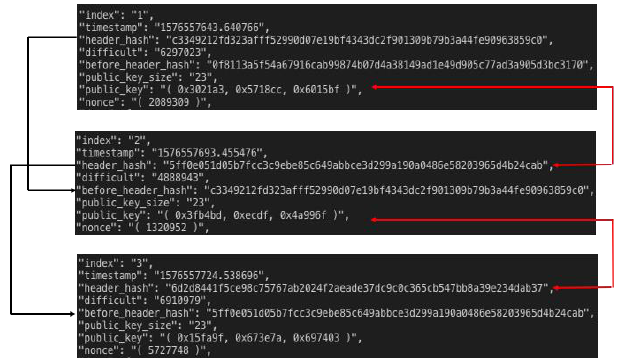
Figure 6. An example of the chained blocks structure.